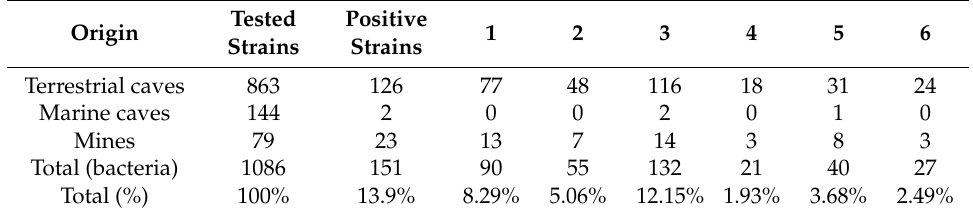
Table 1. Screening of bacteria from mines and marine caves in Alentejo, Algarve, and Andalucia, as well as from the IRNAS-CSIC cave bacterial